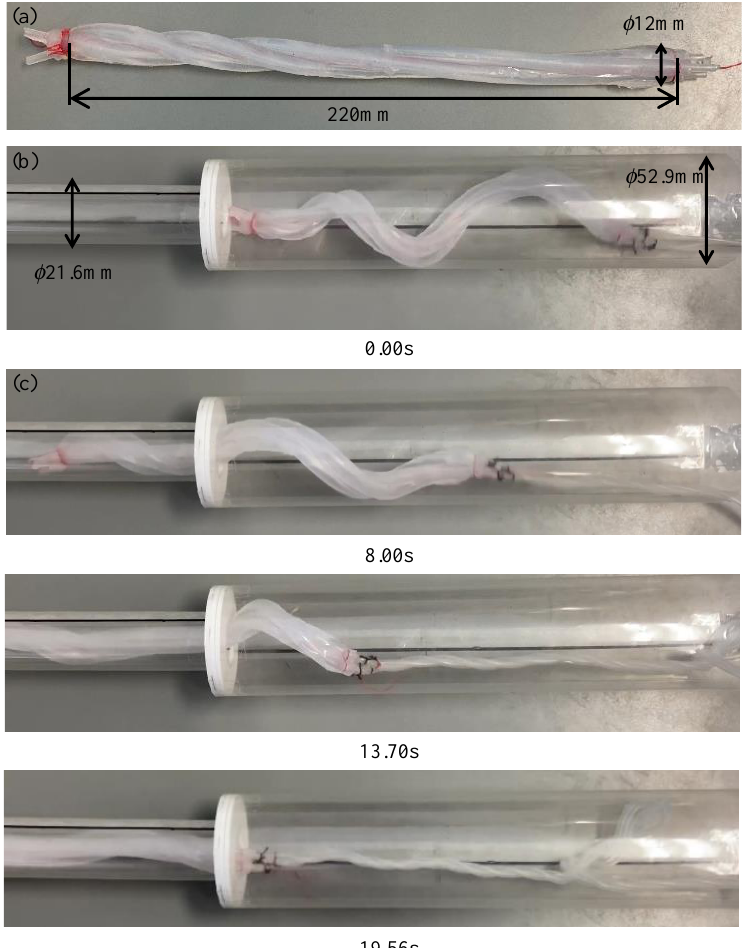
Figure 13. Experiment using a biased pitch device driven by an air pressure of 0.14 MPa in a horizontally fixed pipe with the same diameter as that of the 50A and the 20A pipes. ( a – c ) show the initial shape, the deformed shape, and the process of being inserted into a 20A pipe,